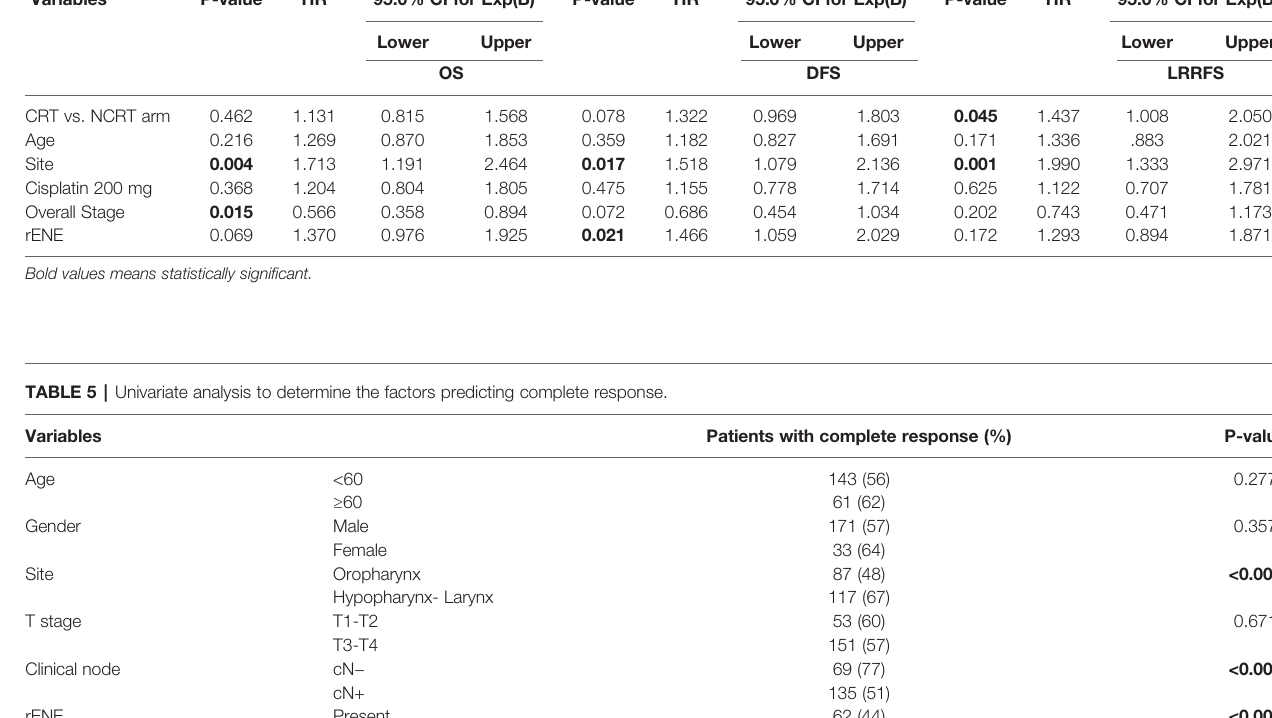
Bold values means statistically signi fi